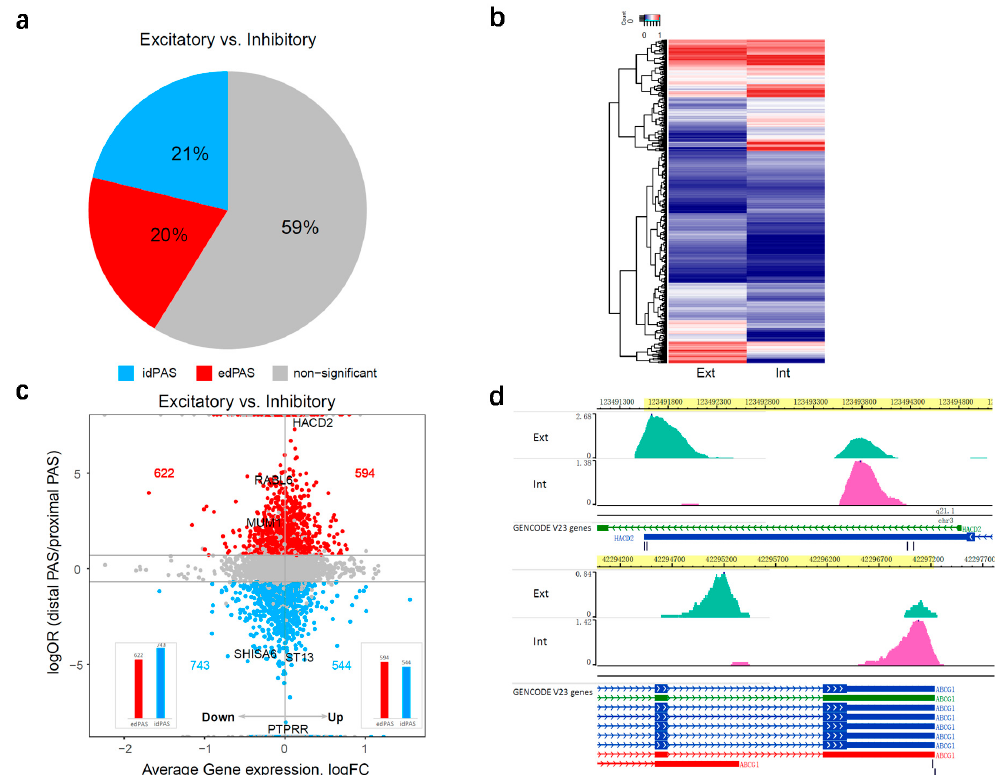
Figure 2. Cell-type specific APA usage in excitatory and Inhibitory neurons. ( a ) Significant changes of top 2 APAs (distal and proximal) usage in excitatory neurons, versus inhibitory neurons based on Fisher’s exact (FDR = 0.05, odd ratio less than 0.5 or more than 2). idPAS indicates inhibitory neuron-enhanced distal PAS usage; edPAS indicates excitatory neuron-enhanced distal PAS usage; ( b ) Differential percent usage of top 2 APAs between excitatory (Ext) and inhibitory (Int) neurons (FDR = 0.05). Colors represent the percentage of distal PAS and proximal PAS for 2503 genes: red indicates a high level, blue indicates a low level; ( c ) Scatterplots showing the relative (fold) change between the average gene expression level in excitatory neurons and inhibitory neurons (excitatory / inhibitory, x axis) response to the relative changes (log odds ratio) between distal PAS and proximal PAS (y axis). Red dots showing edPAS; blue dots showing idPAS; ( d ) snRNA-seq tracks for a cell-type specific APA selection gene (HACD2, ABCG1), showing evidence for di ff erent APA selection in excitatory neurons compare to inhibitory neurons. The colored regions correspond to mapped single cell 3’ RNA-seq reads from each cell group. Green indicates the reads of excitatory neurons (Ext). Pink indicates the reads of inhibitory neurons